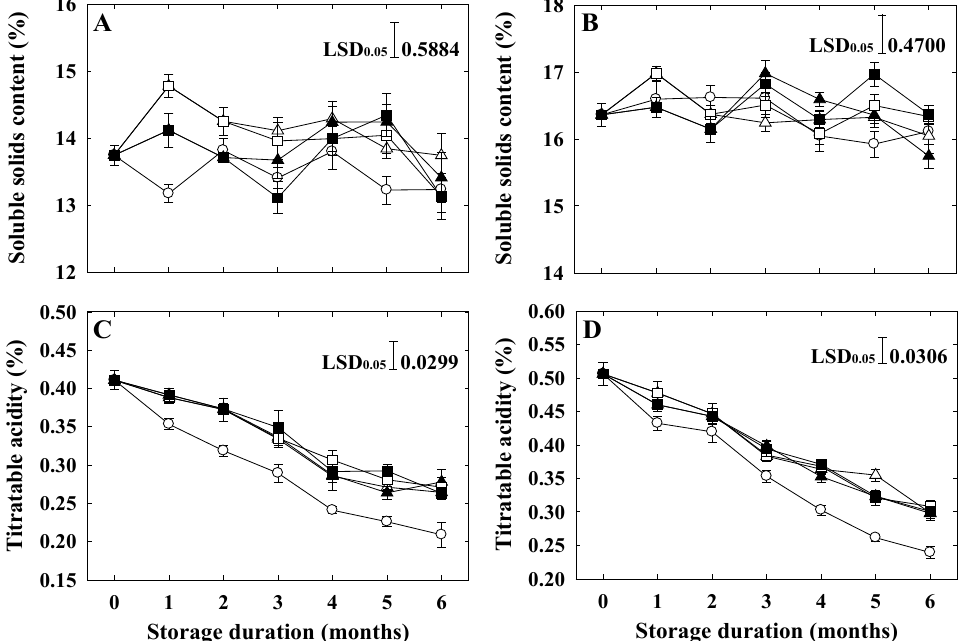
Figure 3. Soluble solids content and titratable acidity of ‘Arisoo’ ( A , C ) and ‘Picnic’ ( B , D ) apples during cold storage at 0 ± 1 °C with 90–95% relative humidity for up to six months. Fruits were treated with 0.5 µ L L − 1 1-MCP ( ∆ ) and 1 µ L L − 1 1-MCP ( (cid:78) ) at harvest, and 0.5 + 0.5 µ L L − 1 1-MCP ( (cid:3) ) and 1 + 1 µ L L − 1 1-MCP ( (cid:4) ) at harvest and 2 months after storage, and untreated as control ( ). Data are presented as mean ± standard error ( n =